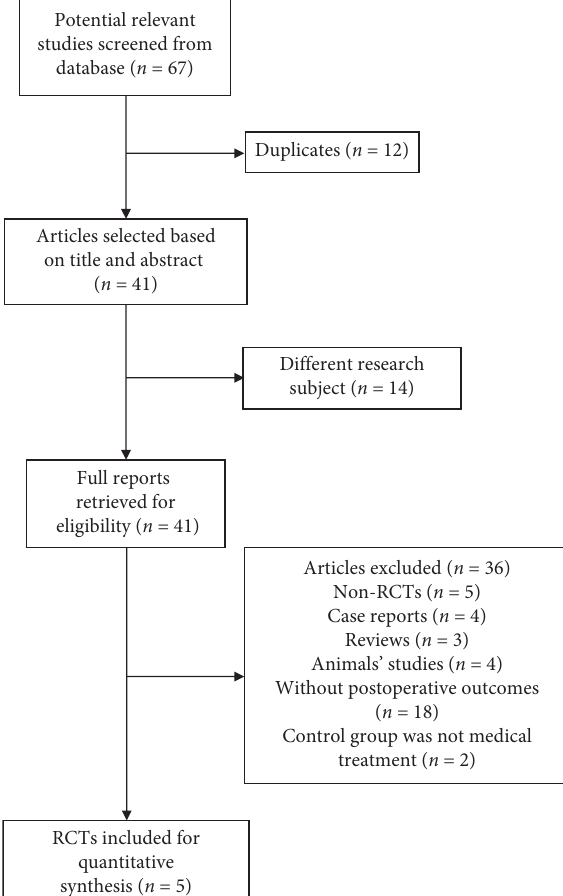
Figure 1: Flowchart of search strategy in this systematic review. RCT, randomized controlled clinical